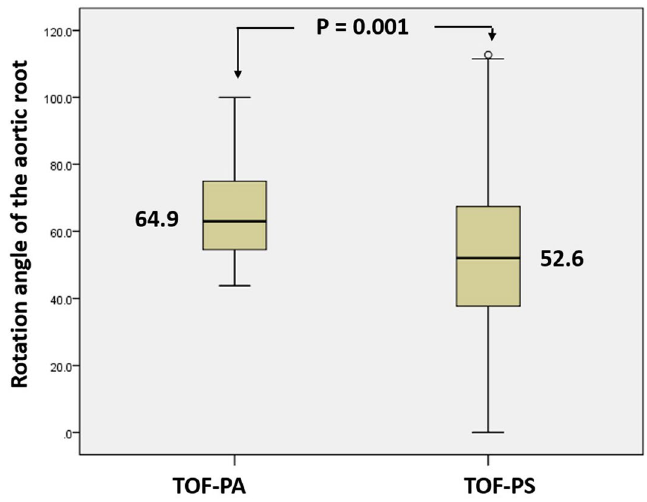
Figure 5. Plot-Box showed the mean of the clockwise rotation angle of aorta root of TOF-PA and TOF-PS which showed a significant difference.